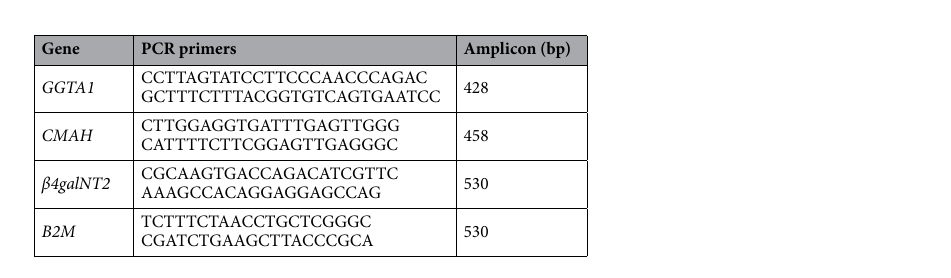
Table 2. PCR primers used to amplify gRNA targeting